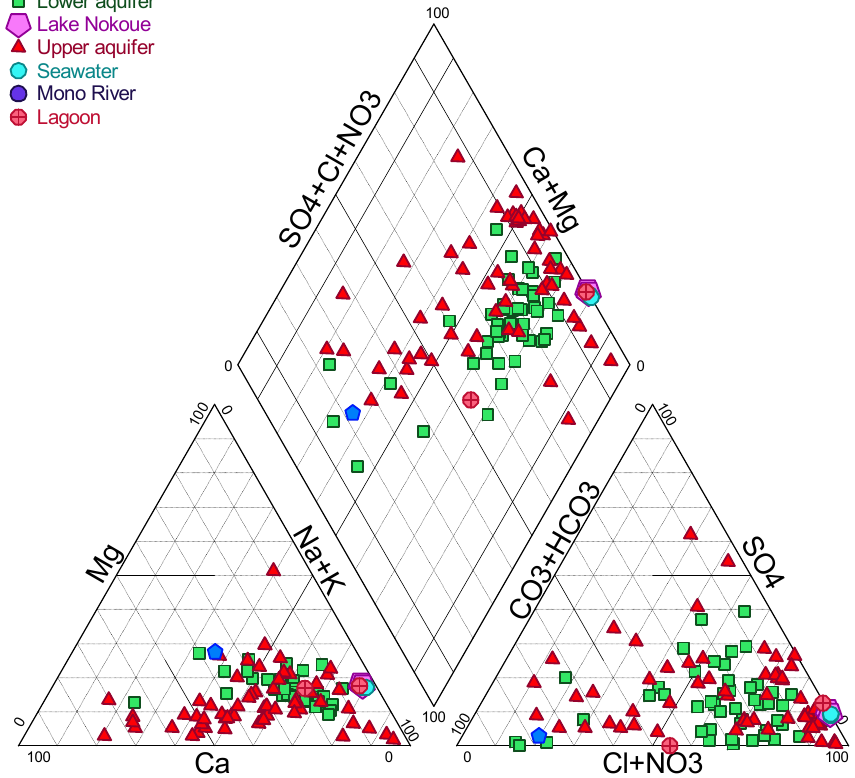
Figure 4. Piper diagram of coastal groundwater in Benin. The chemical composition of seawater, Mono River, Lake Nokoué, and lagoons are also plotted.